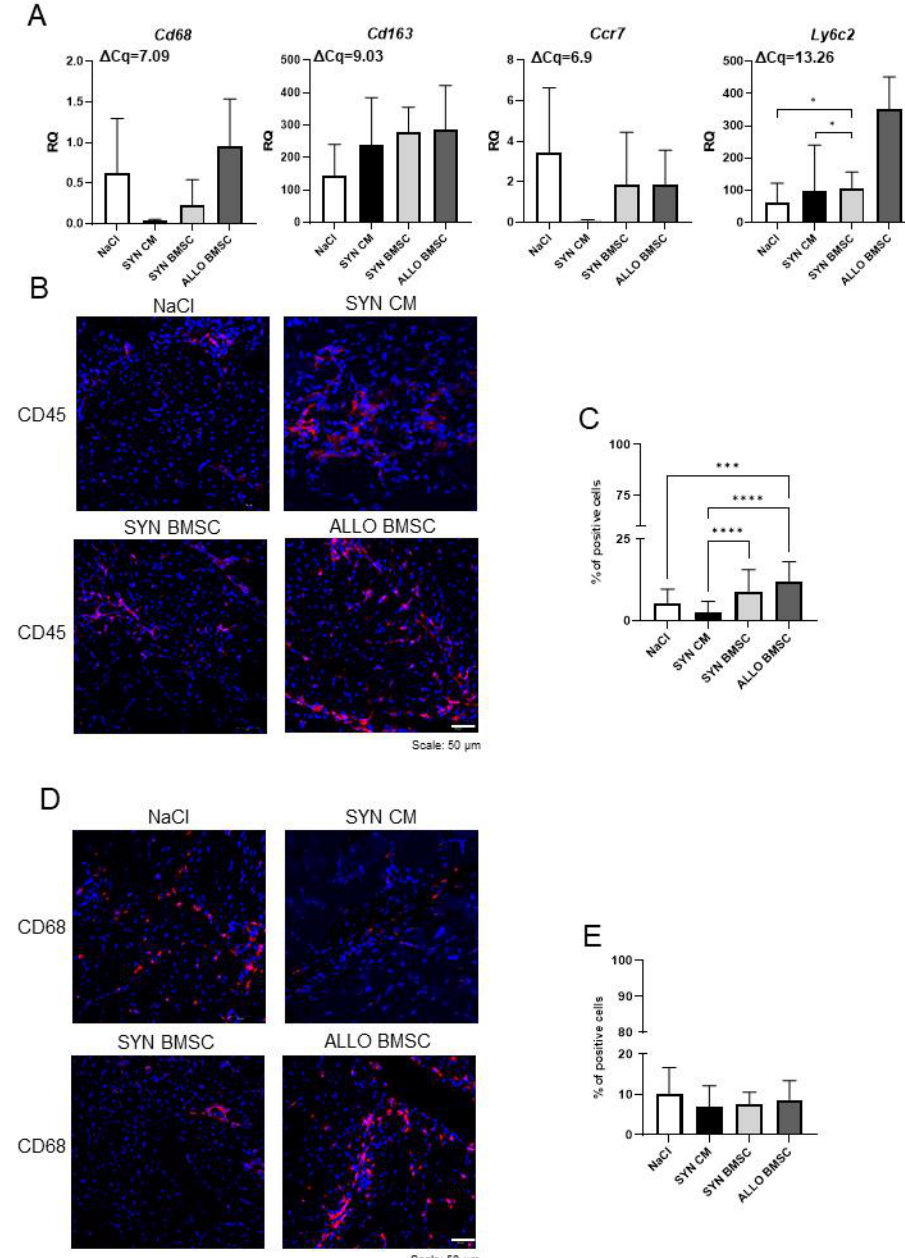
Figure 4. Analysis of immune cell infiltration in regenerating muscles injected with NaCl or SYN CM or SYN or ALLO BMSCs. ( A ) Expression of immune cell markers: Cd68 , Cd163 , Ccr7, and Ly6c2 . Hprt was used as a reference gene. RQ = 1 for the level of gene expression detected in 13.5-day-old mouse embryo (used as reference sample). Average ∆ Cq for the reference sample is shown in each graph. Data are presented as means of three independent experiments with standard deviations. ( B ) Representative images of CD45 immunostaining in the muscles analyzed 14 days after injury. Analyzed proteins are shown in red; DNA in blue. Scale bar: 50 µ m. ( C ) Proportion of CD45 positive cells to all cells counted in sections of analyzed muscles 14 days after injury. For all variants n ≥ 20. ( D ) Representative images of CD68 immunostaining in the muscles analyzed 14 days after injury. Analyzed proteins are shown in red; DNA is shown in blue. Scale bar: 50 µ m. ( E ) Proportion of CD68-positive cells to all cells counted in analyzed muscle sections 14 days after injury. For all variants n ≥ 20. Data found to be statistically significant are underlined on graphs and are marked with asterisks (* p < 0.05; *** p < 0.001; **** p <